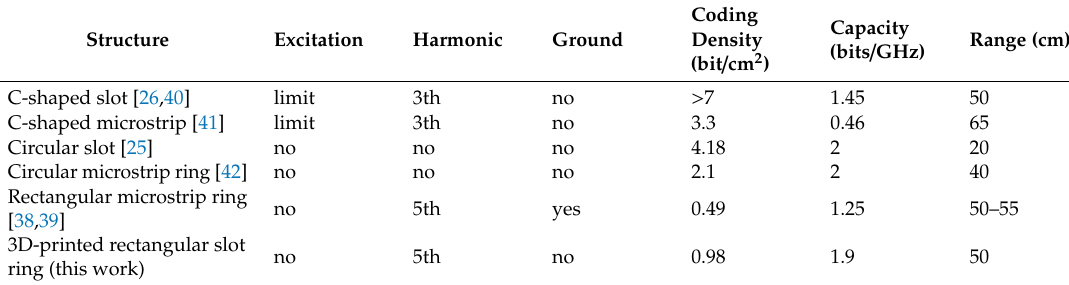
Table 4. Comparisons of di ff erent structures’